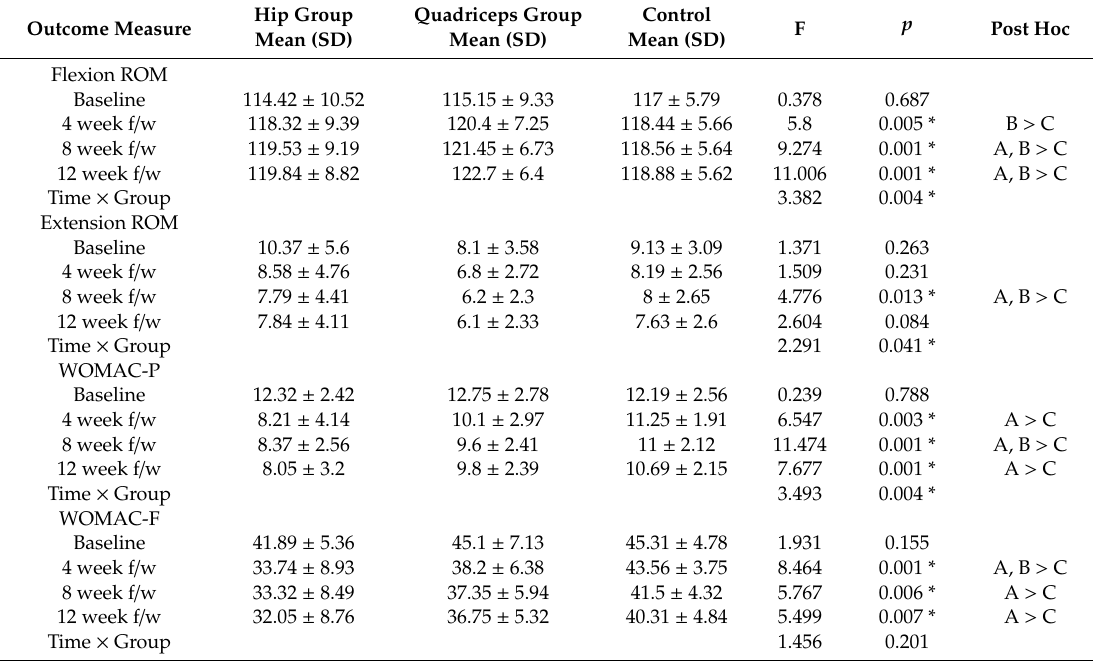
Table 4. Outcome scores for each group at baseline (week 0), post-intervention (week 4), follow-up (week 8), and follow-up 2 (week 12): mean and standard deviation.